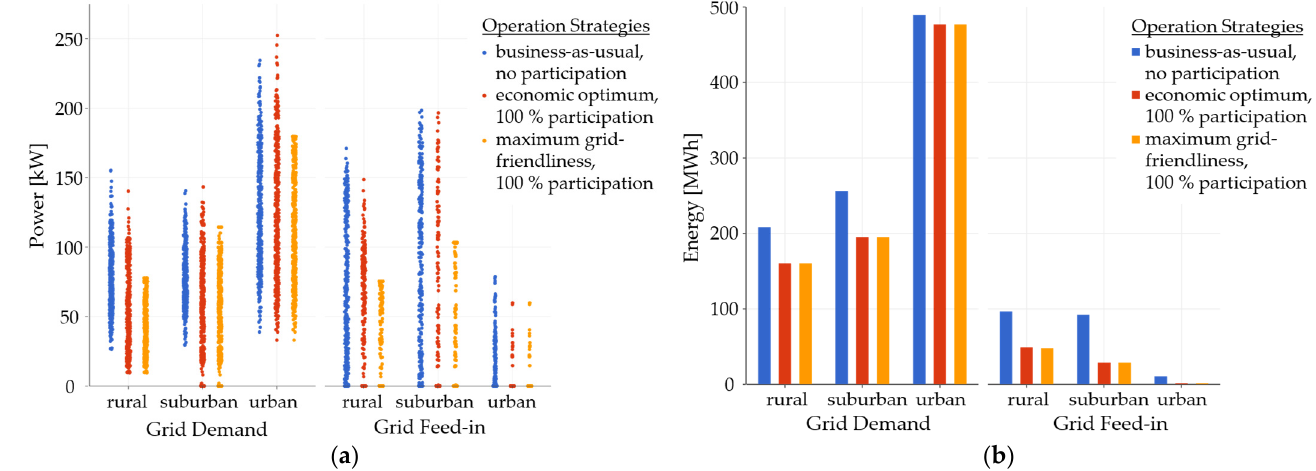
Figure 3. Comparison of operation strategies in rural, suburban, and urban grid topology regarding external grid exchange with respect to: ( a ) daily peak power at the low-voltage transformer, separated into demand and feed-in; ( b ) total energy demand and feed-in via the low-voltage transformer. Table 3. Annual peak power at the low-voltage transformer for operation strategies and scenarios. Operation Strategy